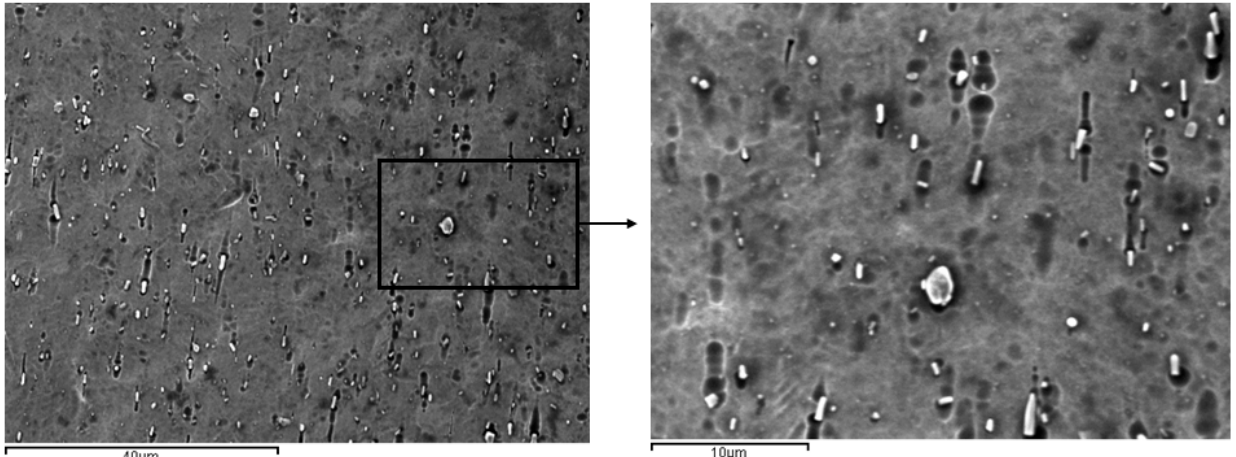
Figure 7. NiTi archwire surface after the immersion for 14 days in mouthwashes with 380 ppb of fluoride. Titanium-rich precipitates are observed on the surface.